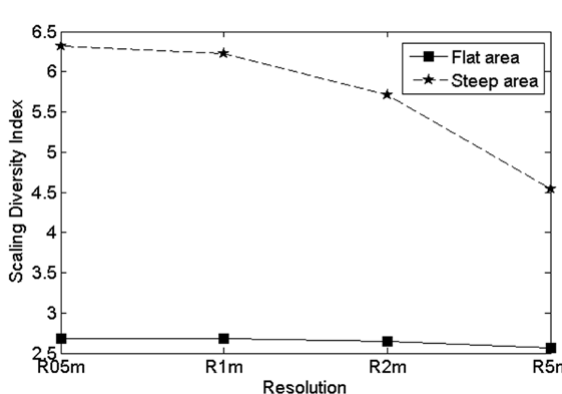
Fig. 3. Scaling diversity index for different resolutions of DEM